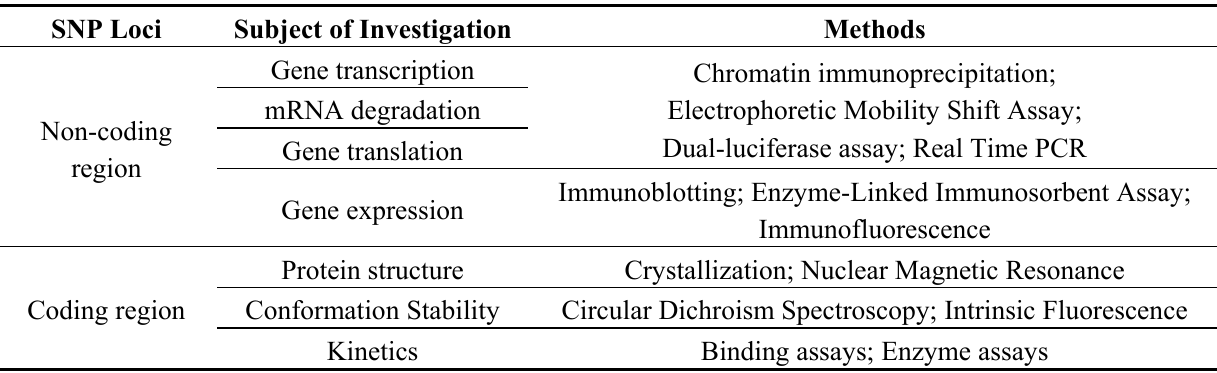
Table 1. Important methods and technological developments for understanding various single nucleotide polymorphism (SNP)